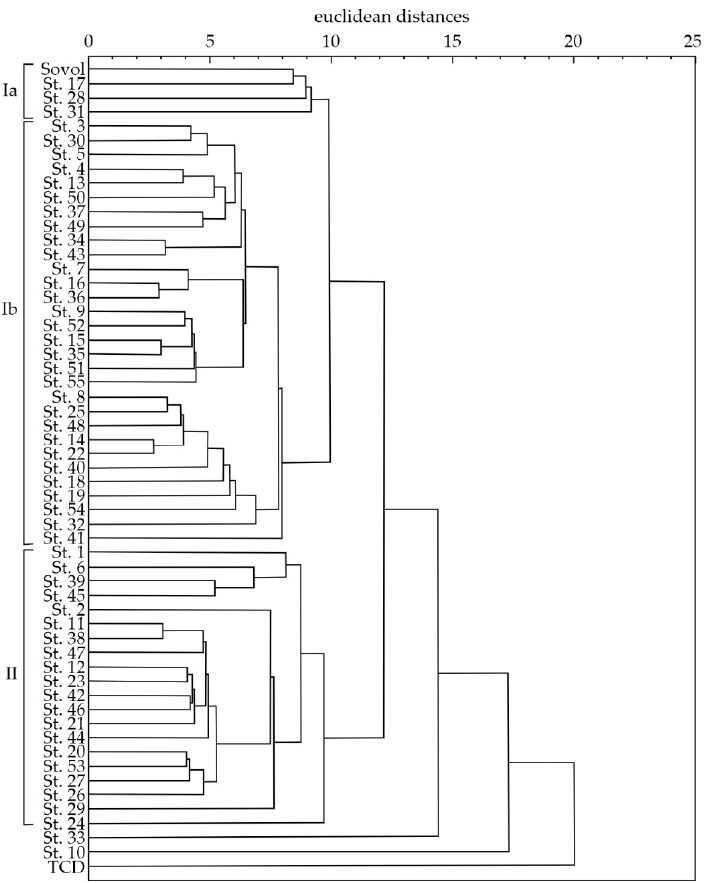
Figure 4. The grouping of snow sampling sites by relative PCB homological patterns using the cluster method.